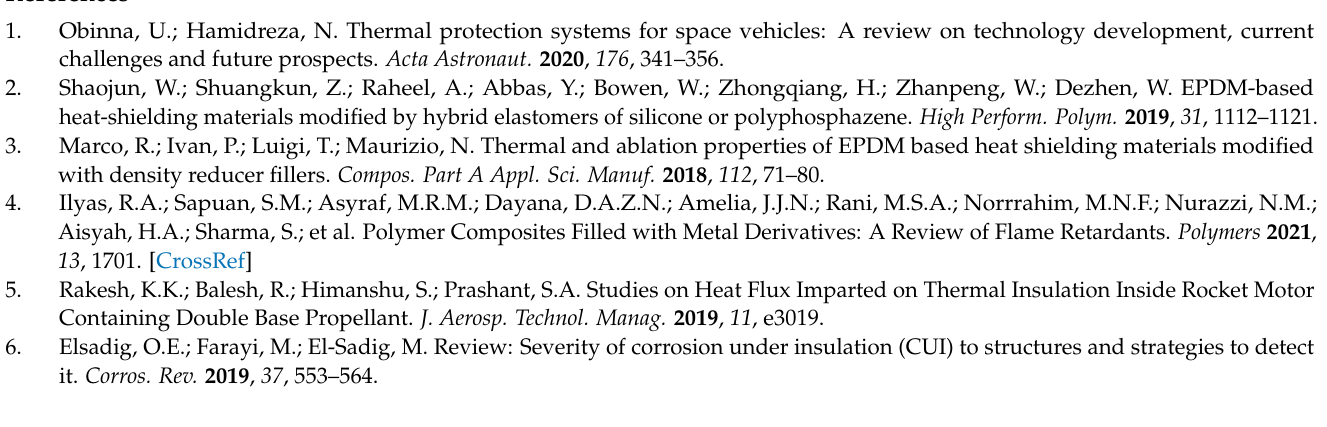
Figure S2: EDS spectra and SEM images of some samples of phase-2 composites. Figure S3: EDS spectra and SEM images of some samples of phase-3 composites. Table S1: Tensile stress and tensile strain values of phase -1, -2 and -3 composites. Table S2: Linear and mass ablation values of